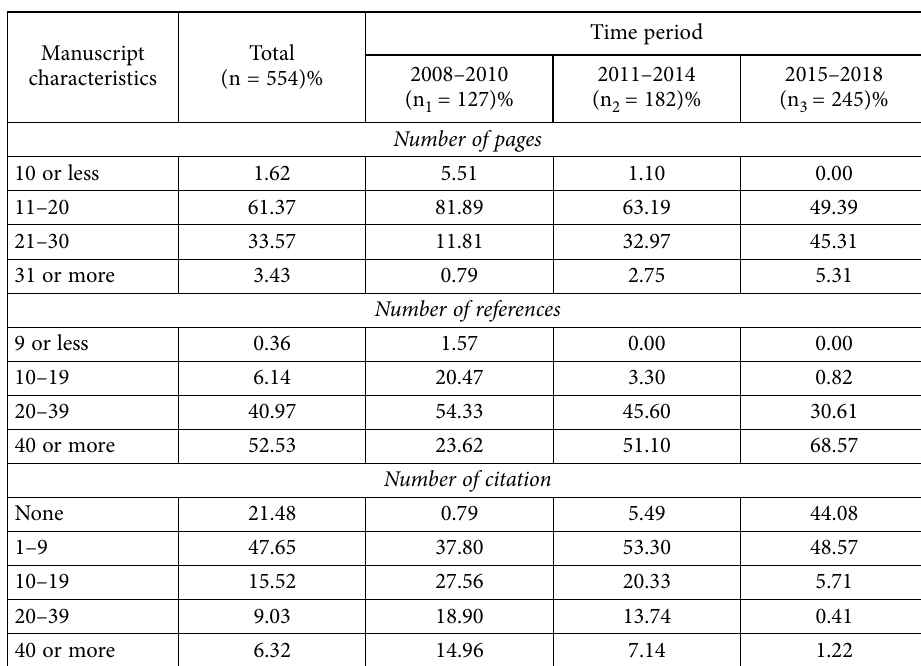
Table 4. Characteristics of the TEDE